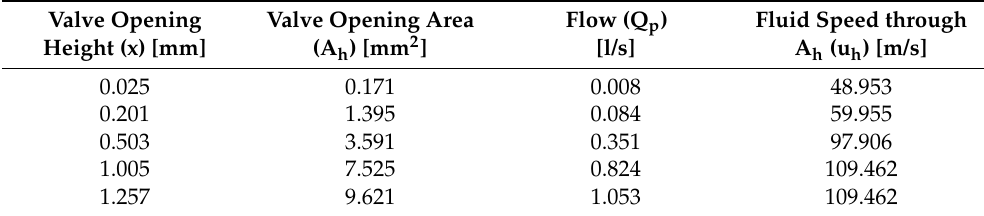
Table 5. Opening area, flow and velocity of the fluid through the valve − 50 ◦ C. Valve